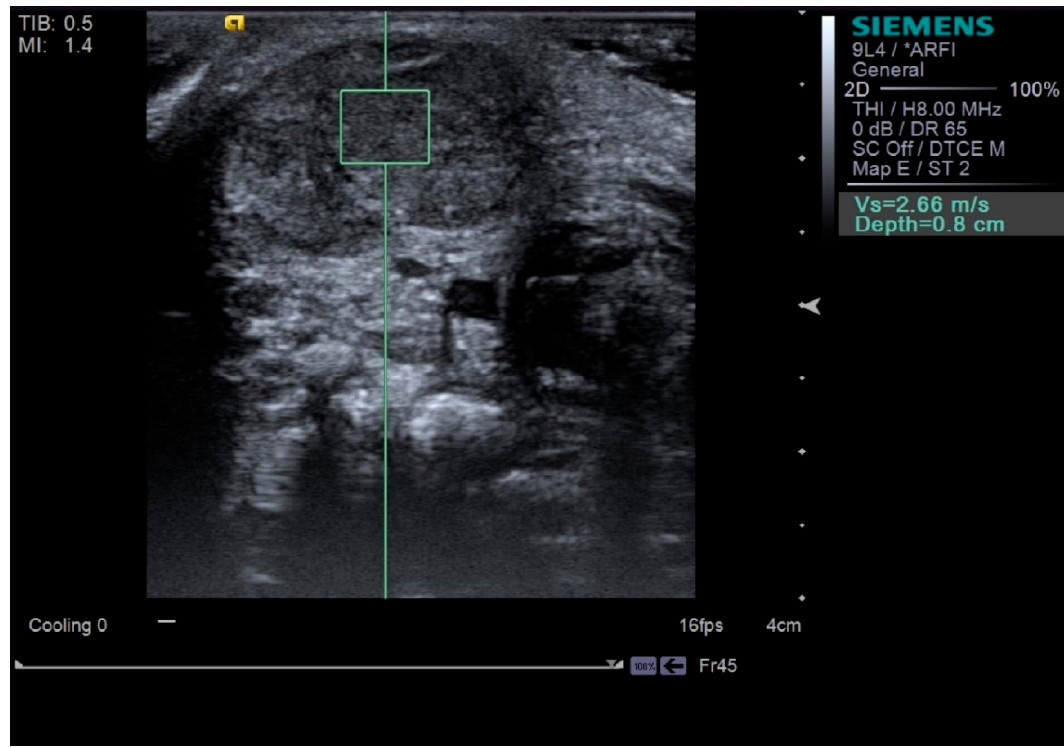
Figure 3. Shear-wave velocity measured by scanning in the transverse plane at the bulbous portion of the sternocleidomastoid muscle (green square means the region of interest).